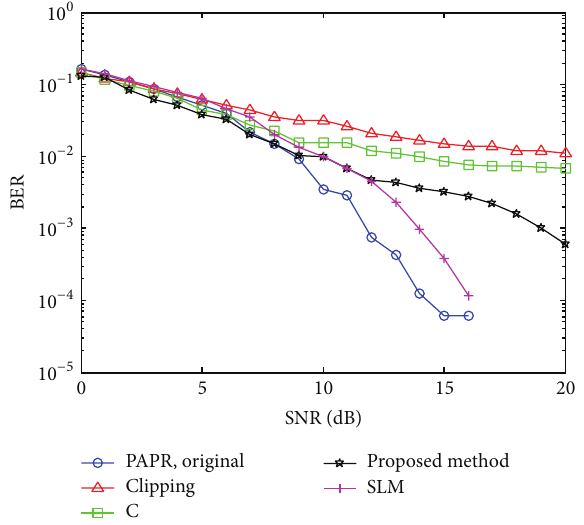
Figure 7: Influence of different method on OFDM system.